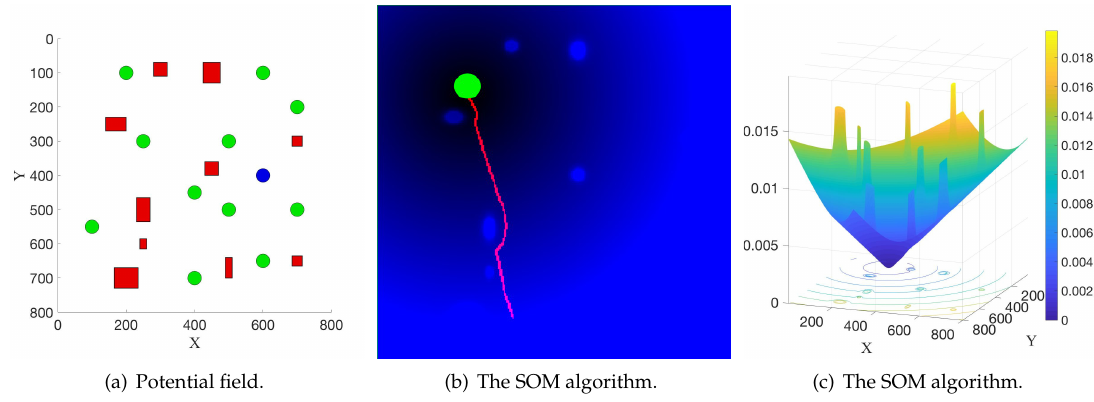
Figure 3. Socially compliant path planning for robotic autonomous luggage trolley